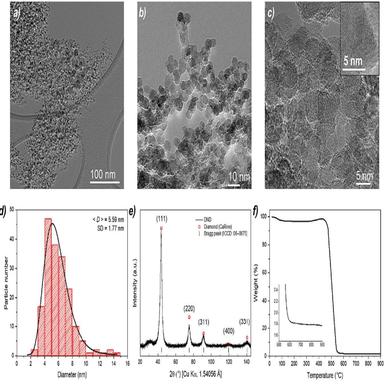
a)–b) TEM images of detonation nanodiamonds at different magnifications and c) HRTEM image of the same sample, insert: zoom-in on a ND particle. d) Size distribution of DND with a log normal distribution function (black curve), calculated based on 183 particles. The mean diameter is note 〈D〉, while the standard deviation is abbreviated SD. e) PXRD pattern (Cu, 1.5406 Å) of as-received DND. The black line is the experimental pattern, the red circles are the simulated pattern for diamond, based on CaRine soft